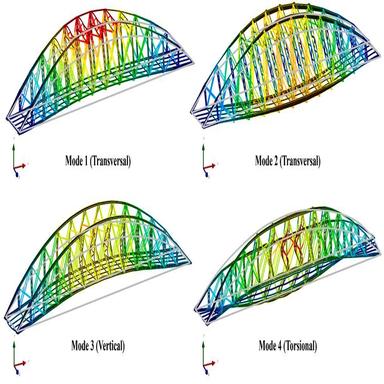
Numerical mode shapes after model calibration.